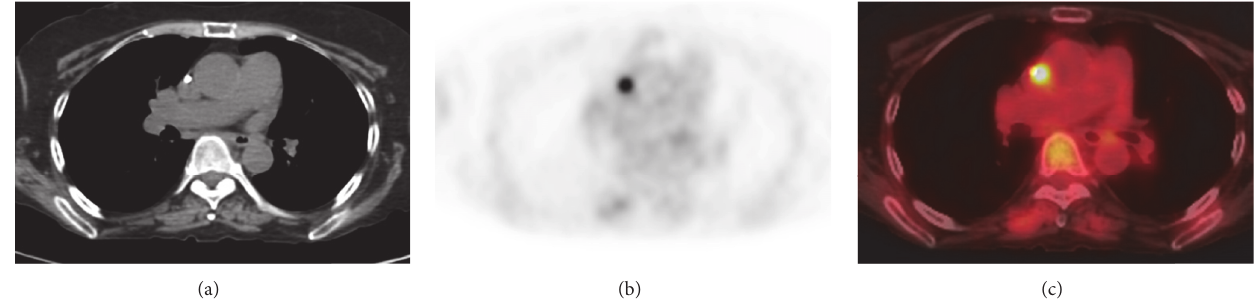
Figure 2: FDG PET/CT exam. Axial CT (a), PET (b), and (c) fused images from PET/CT exam demonstrate moderately hypermetabolic focus correlating with the catheter tip on